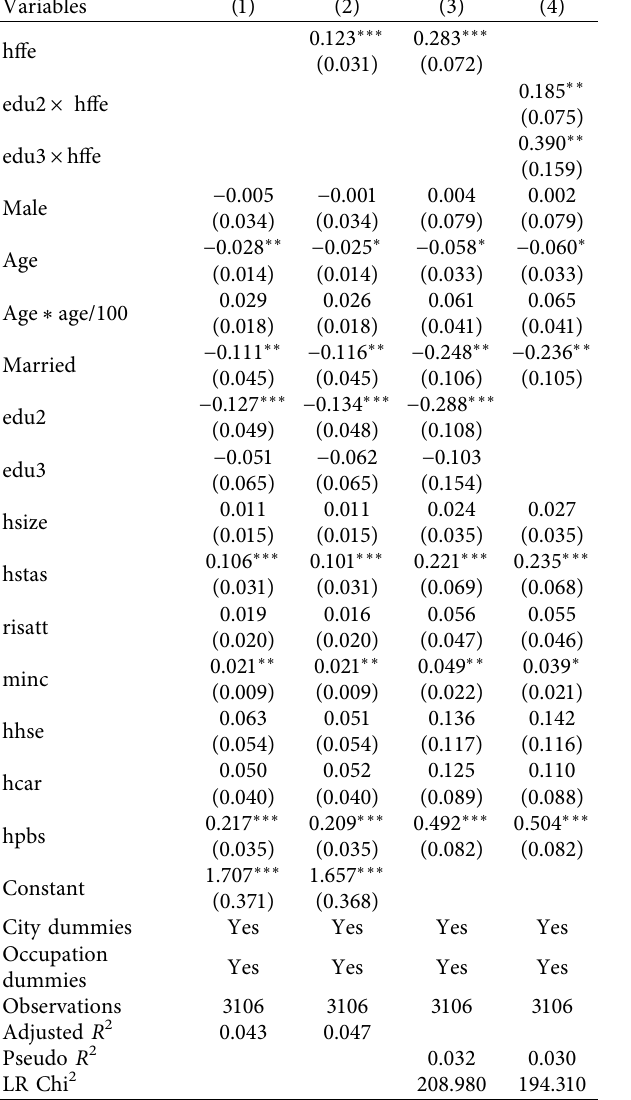
Table 6: Results of regressions of fnancial education on consumer stock market